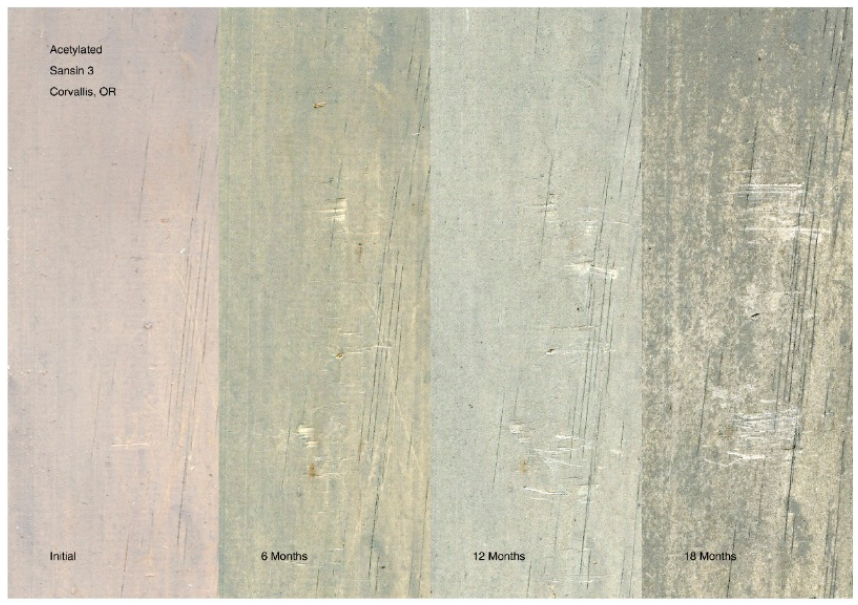
Figure 10. Examples of the same sample of acetylated wood treated with Sansin 3 and exposed for 0, 6, 12, and 18 months near Corvallis, OR (left to right).